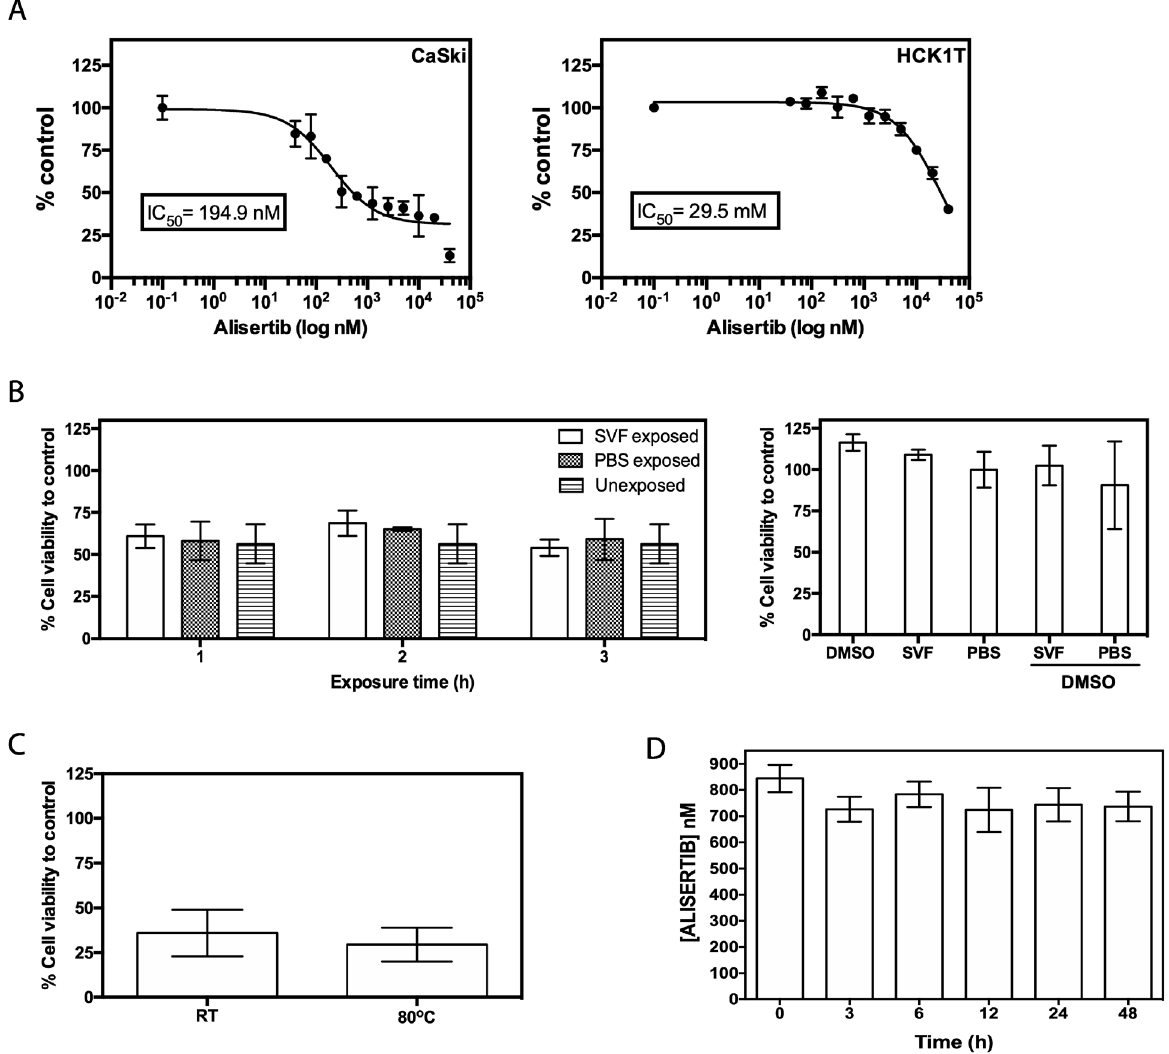
Fig 2. HPV-transformed cervical cancer cells were sensitive to ALISERTIB treatment and bioactivity unchanged upon exposure to simulated vaginal fluid and high temperature conditions. (a) CaSki and HCK1T cells were treated with ALISERTIB at doses ranging from 40mM to 40nM in a 96 well plate. Cell viability was measured by the MTT assay at 3- and 6-days’ post-treatment for CaSki and HCK1T, respectively. A dose dependent curve was generated using Graphpad Prism v8 to determine IC50 values for each drug-treated cell line. Data points are representative of the mean ± standard deviation (SD) (n = 3). CaSki cells were treated with 200nM of ALISERTIB (b) either unexposed or exposed to simulated vaginal fluid (SVG) or PBS for the indicated length of time or (c) subjected to heating at 80˚C or left at room temperature (RT) for 30min. After 72h, cell viability was measured by the MTT assay. Data is representative the mean ± SD percentage cell viability of treated to untreated (control) cells. (d) 1 mg/ml ALISERTIB (1% w/v) was dissolved in 50% isopropanol/H2O over time at 37 ˚C before measuring the concentration of ALISERTIB by HPLC. Data is representative of mean ±